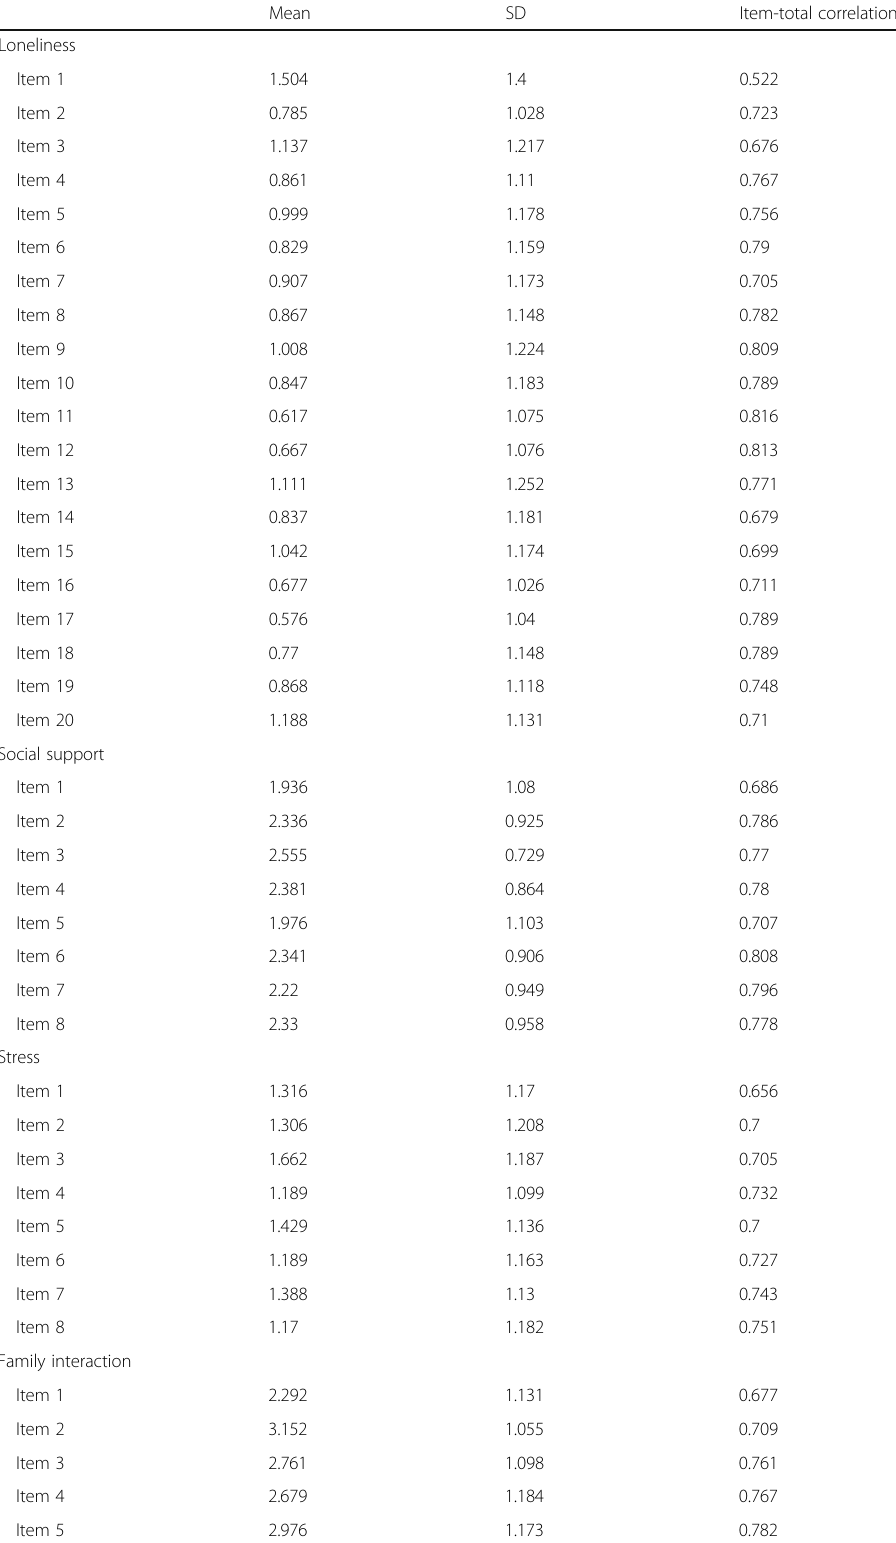
Table 1 Item Statistics: Mean, Standard Deviation and Item-total Correlation Mean SD Item-total